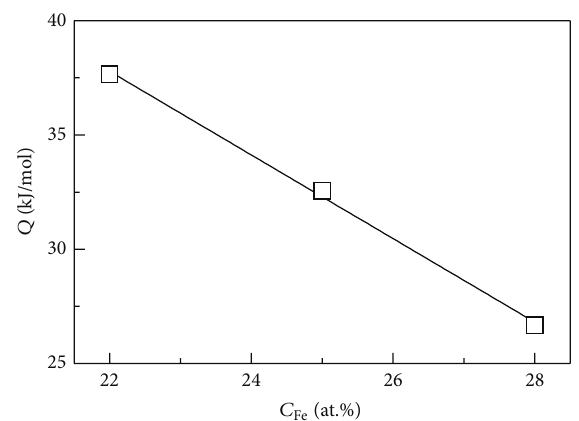
Figure 10: Relationship between the diffusion activation energy and Fe